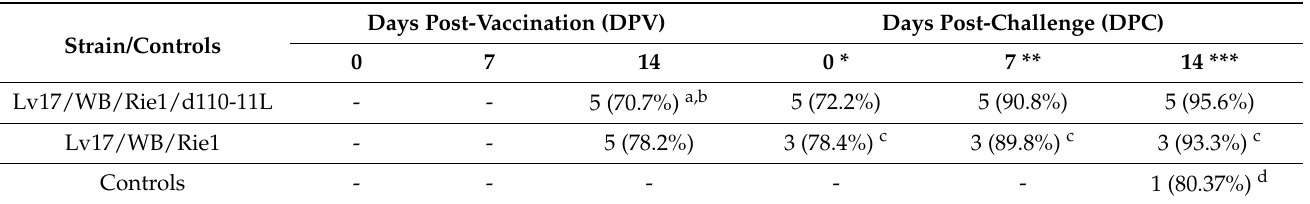
Table 7. Antibody response of pigs immunized with different African swine fever virus (ASFV) strains and challenged with Armenia/07 of